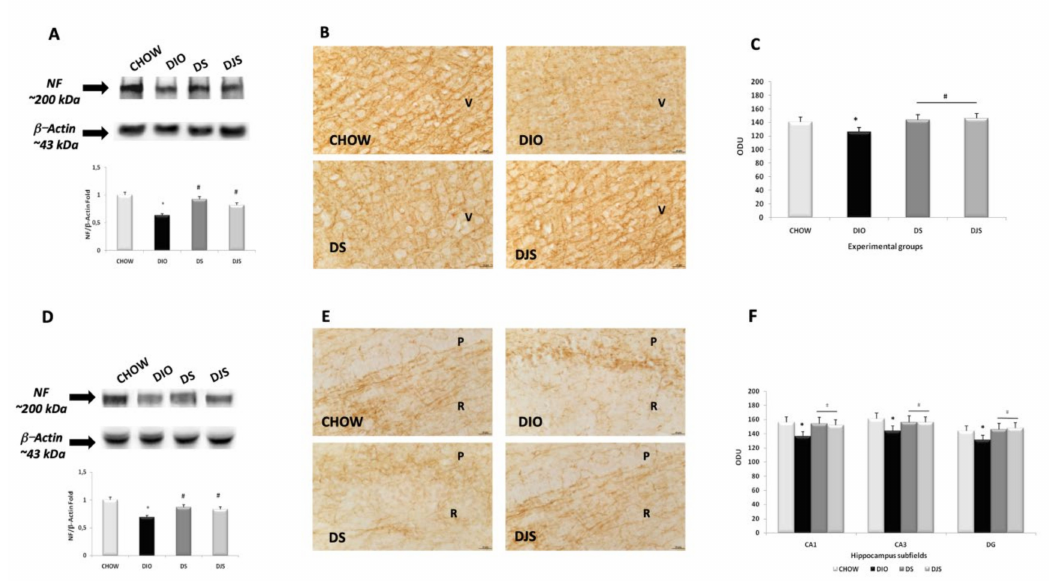
Figure 3. Expression of neurofilament in the di ff erent brain areas. Western blot analysis (representative of three di ff erent experimental sessions) for samples of the frontal cortex ( A ) and hippocampus ( D ) were probed for NF and β -Actin, with corresponding densitometric analysis of the bands. Sections of the frontal cortex ( B ) and CA1 subfield of the hippocampus ( E ) were processed for neurofilament immunohistochemistry, with densitometric analysis of the immunoreaction intensity for the frontal cortex ( C ) and hippocampus ( F ). V, fifth layer of the frontal cortex; P, pyramidal neurons; R, stratum radiatum of the hippocampus. The values are the mean ± S.E.M.; ∗ p < 0.05 vs. CHOW rats; # p < 0.05 vs. DIO rats Calibration bar: 25 µ